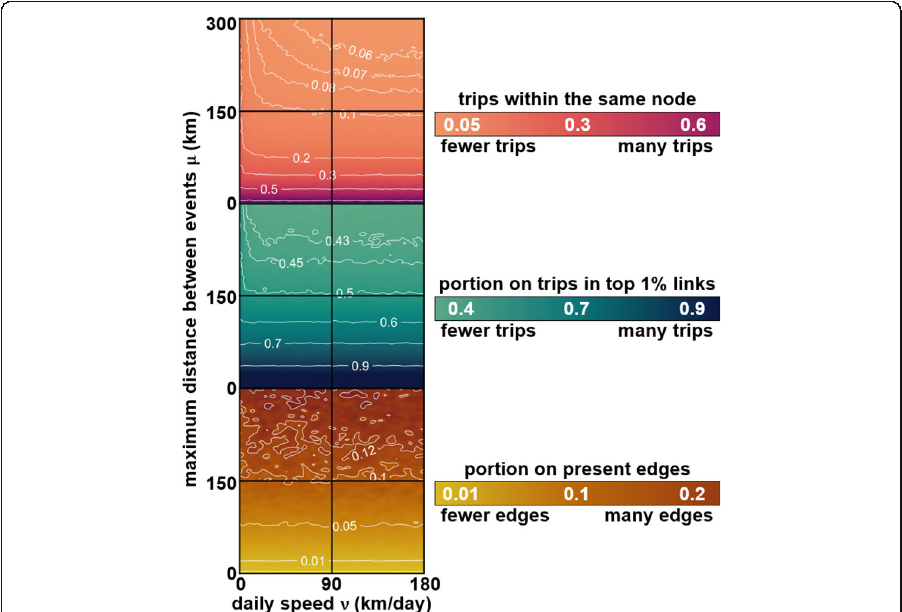
Fig. 7 For each combination of the daily speed ν and the maximum distance between two events μ , a spatial network was constructed. We measure the percentage of trips completed inside the same node (top), the percentage of trips which happen within the top 1% of the edges (middle) and the percentage of present edges (bottom). With a speed of ν = 60 kilometres and a maximum distance of μ = 180 kilometres, roughly 8% of the trips happen inside the nodes, nearly 50% of the trips happen within the top 1% of the edges and only 12% of the edges are present